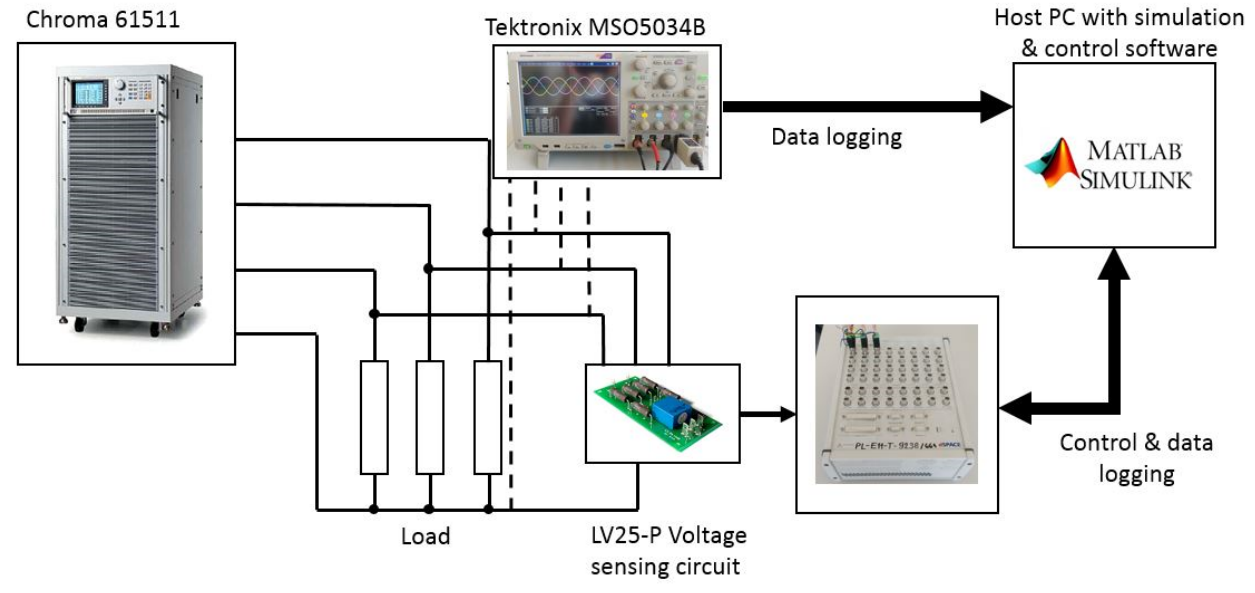
Figure 8. Test bench diagram.